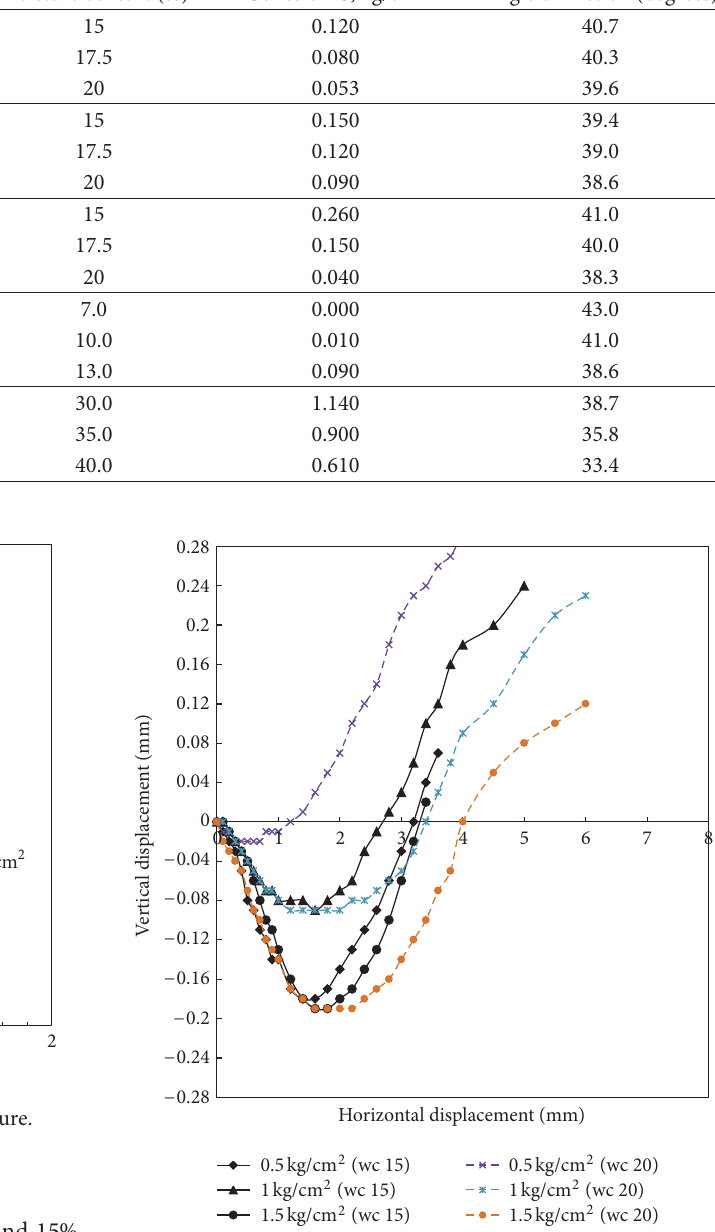
F 7: Vertical displacement versus horizontal displacement obtained from direct shear test.